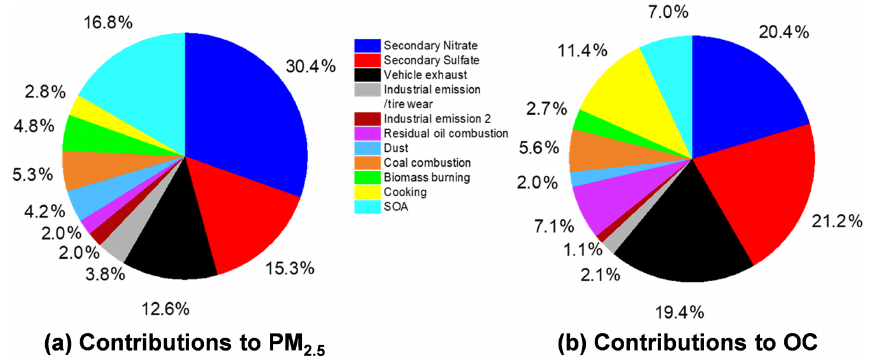
Figure 5. Percentage contributions of individual source factors to (a) PM 2 . 5 and (b) OC based on